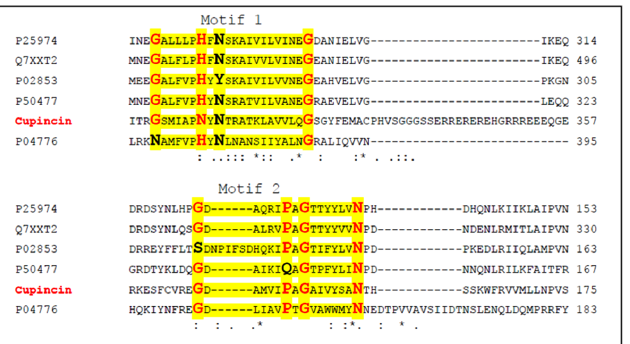
Fig 12. Cupincin as bicupin. Multiple sequence alignment of cupincin with trimeric seed storage proteins (bicupins) showing two conserved domains (highlighted in yellow with consensus sequence indicated in bold red). The sequences utilised for alignment are as follows. P25974 [50], P50477 [51], P02853 [52], P04776 [61], Q7XXT2